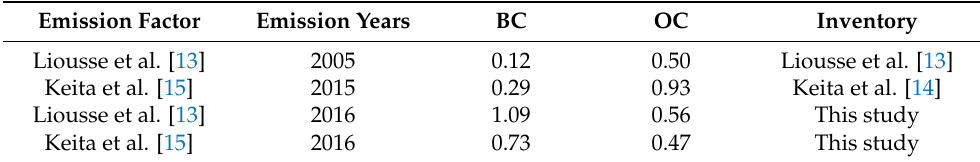
Table 4. Emission factors (EFs) from previous studies used to calculate traffic emission in Yopougon (t/d). Emission Factor Emission Years BC OC Inventory Liousse et al. [13] 2005 0.12